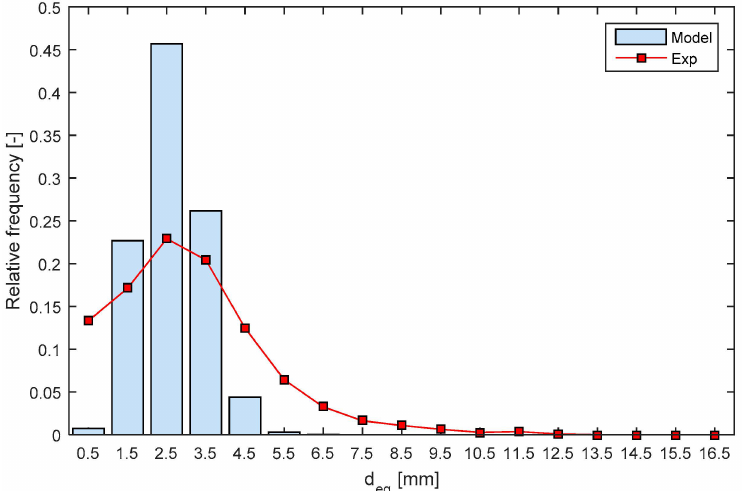
Figure 7. Comparison between PBM and experimental data: uniform bubble size distribution (BSD) at the inlet: U G = 0.0037